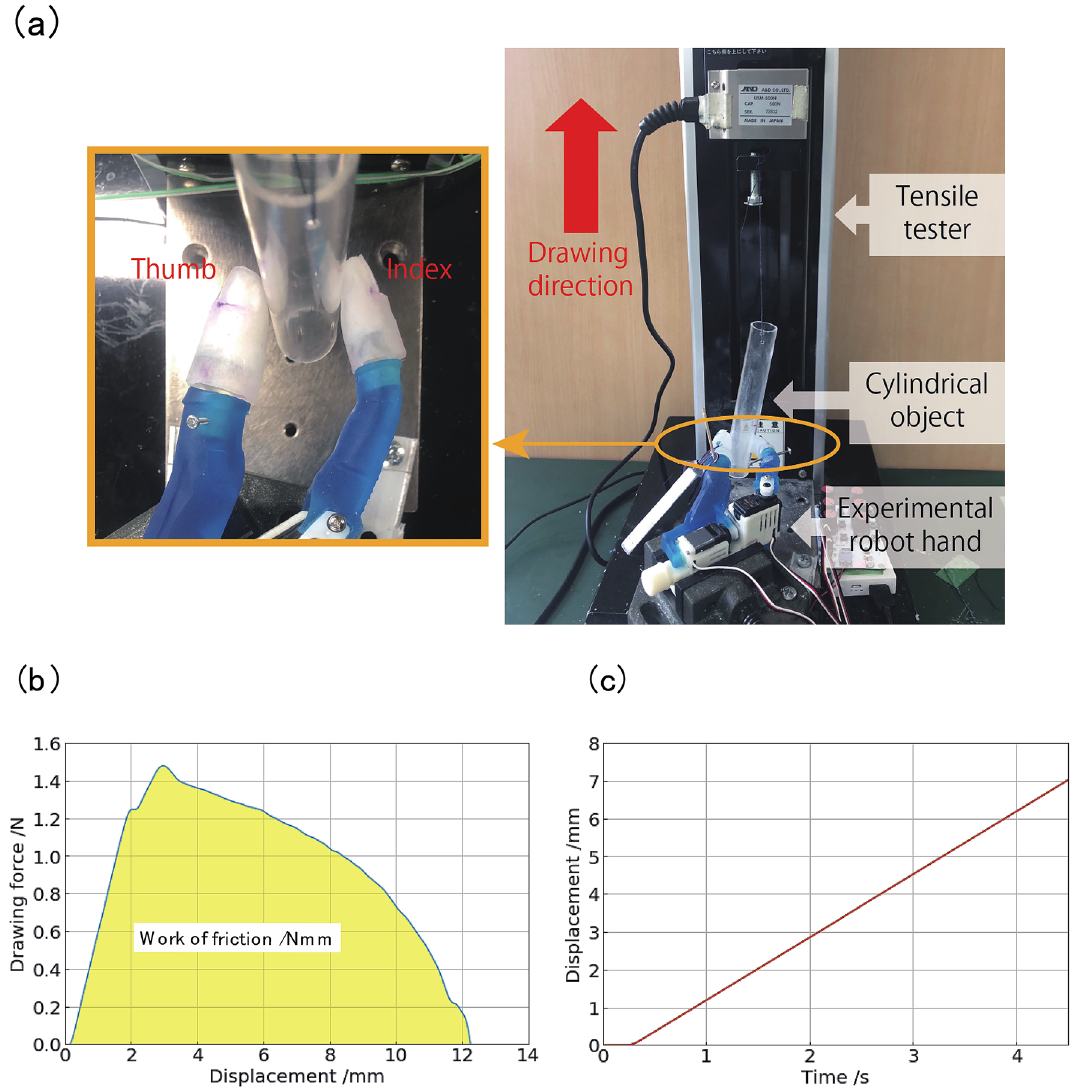
lifted up by the tensile tester. ( b ) Obtained waveforms. Representative examples of waveforms obtained during the pull-out experiment. ( c ) Time-displacement plot resulting from the pull-out experiment. The time variation of the displacement is